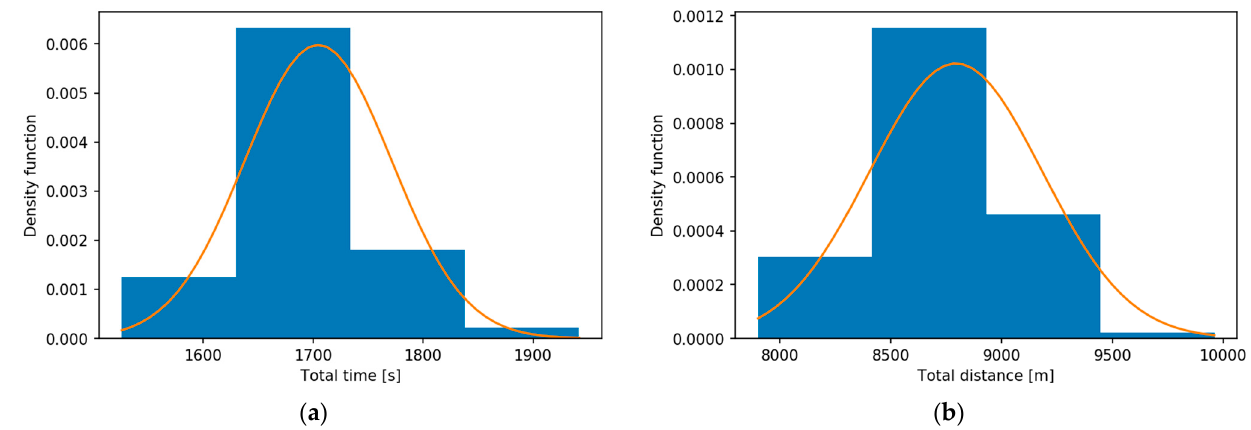
Figure 3. Histograms for all MTSP routes according to time( a ) and distance( b ).